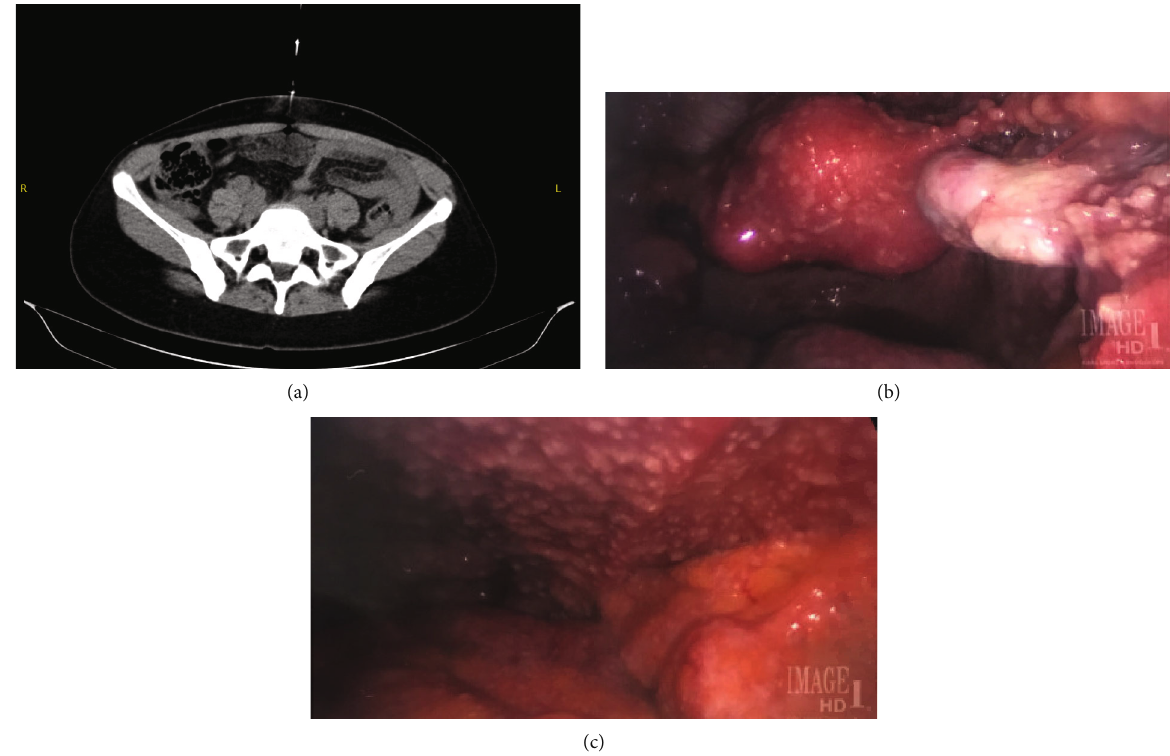
Figure 1: (a) Computed tomography (CT) imaging of the pelvis at the time of presentation and needle biopsy of omental caking. (b) Diagnostic laparoscopy showing innumerable tan, 1-2mm nodules on the surface of the right ovary and uterus. (c) Diagnostic laparoscopy showing innumerable tan, 1-2mm nodules on the anterior abdominal